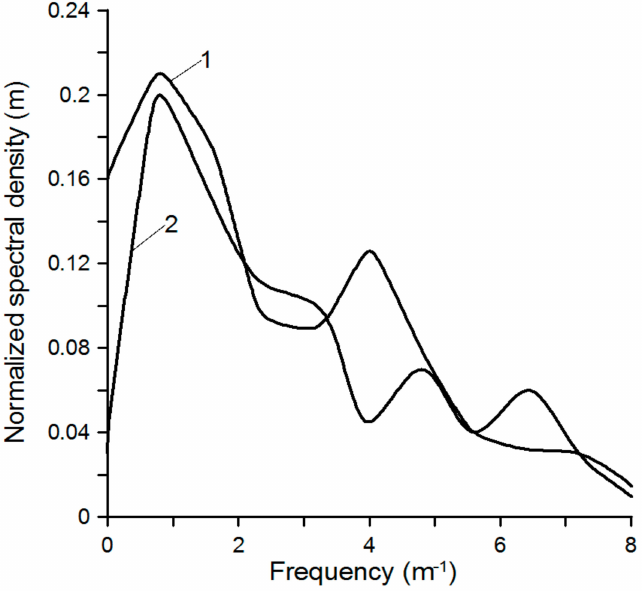
Figure 10. Normalized spectral densities of oscillations of the surface’s longitudinal profile (1) and plowing depth